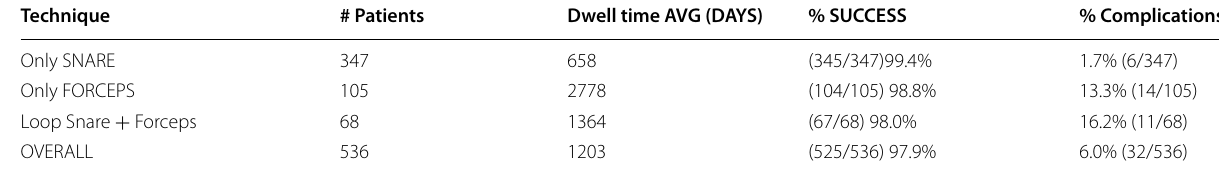
Table 4 IVC filter retrieval data stratified by retrieval technique. Success rate, complication rate, and dwell time are recorded Technique